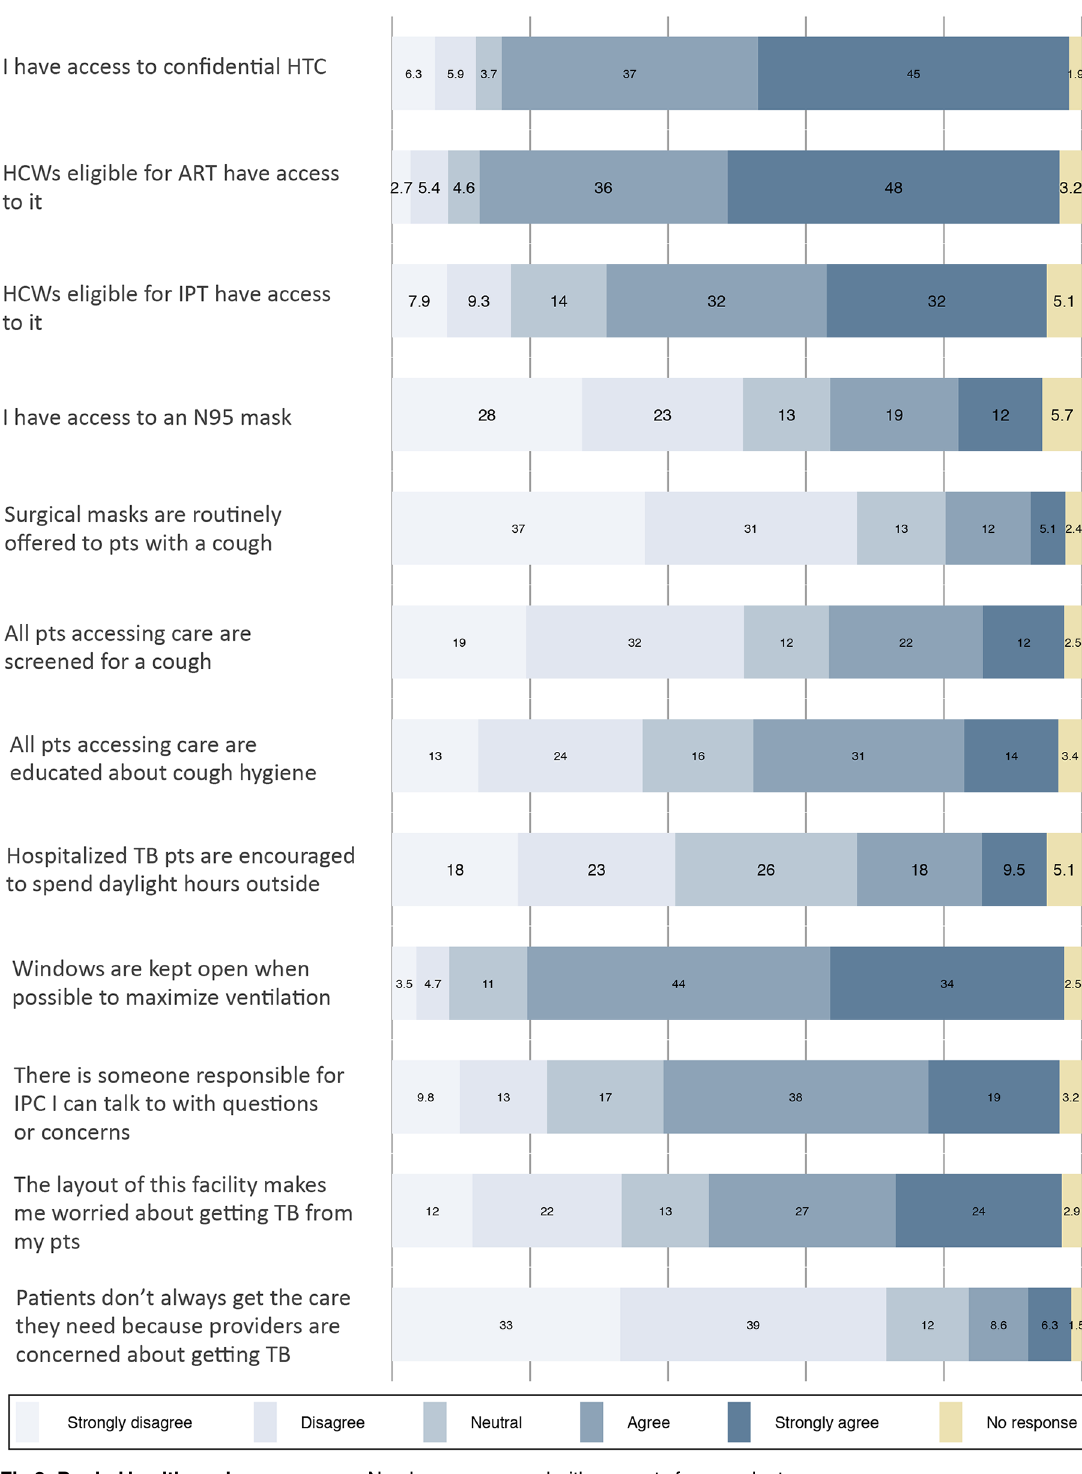
Fig 2. Pooled health worker responses. Numbers correspond with percent of respondents.